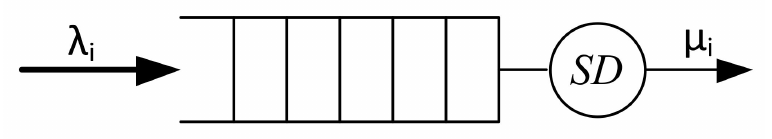
Figure 5. Router virtual machine model for VoIP